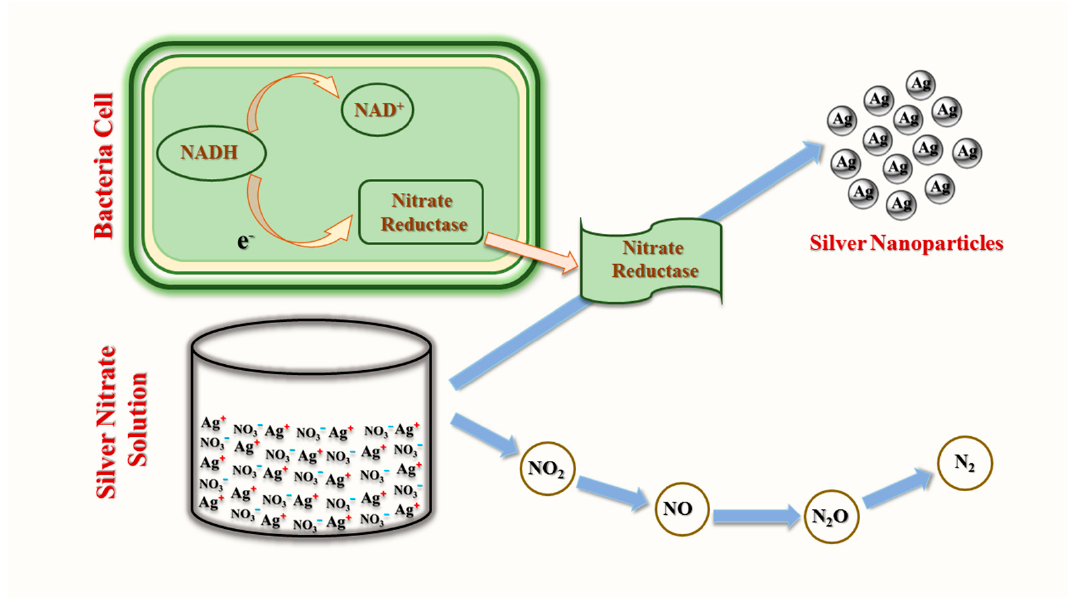
Figure 2. Extracellular enzymatic bacterial synthesis of AgNPs (modified from [54]).